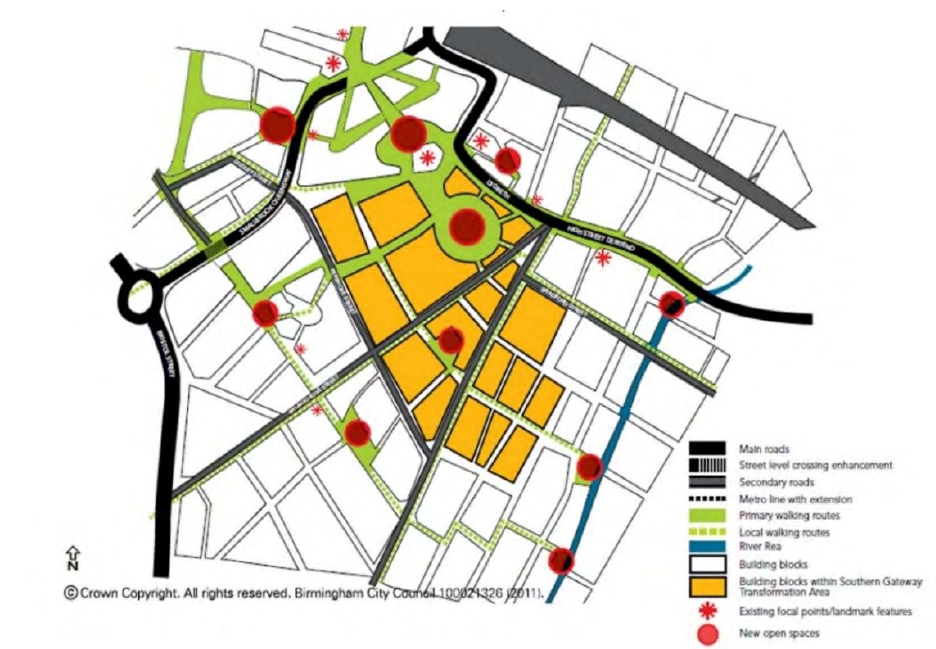
Figure 4. (Public Realm Network of the historical heart of Birmingham